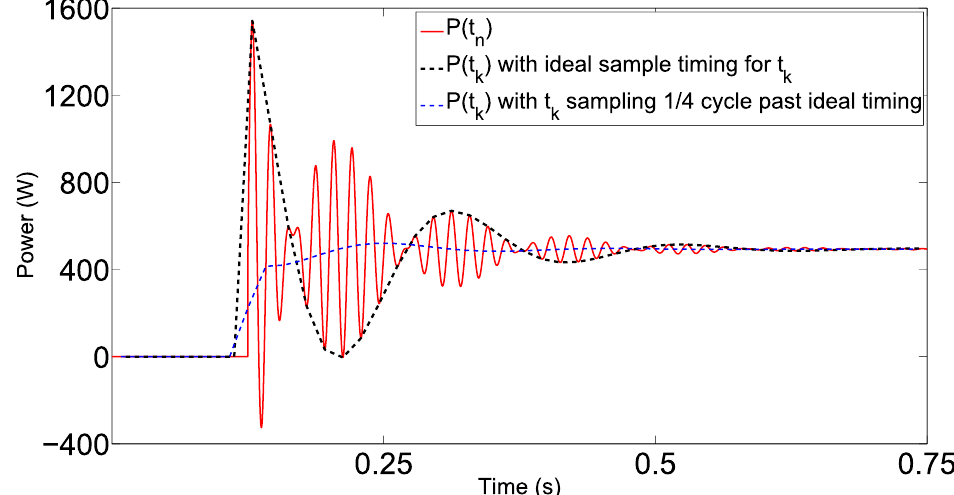
Figure 4. Effect of sample timing, illustrating the correct power envelope only when sampled at the correct timing relative to start of power disturbance.